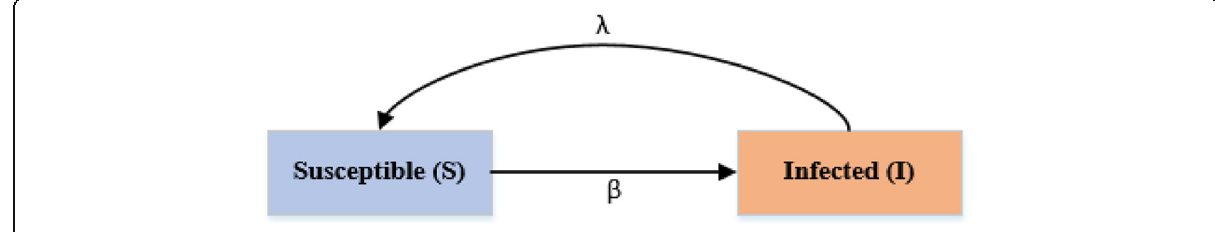
Fig. 3 Schematic representation of the SIS Diffusion